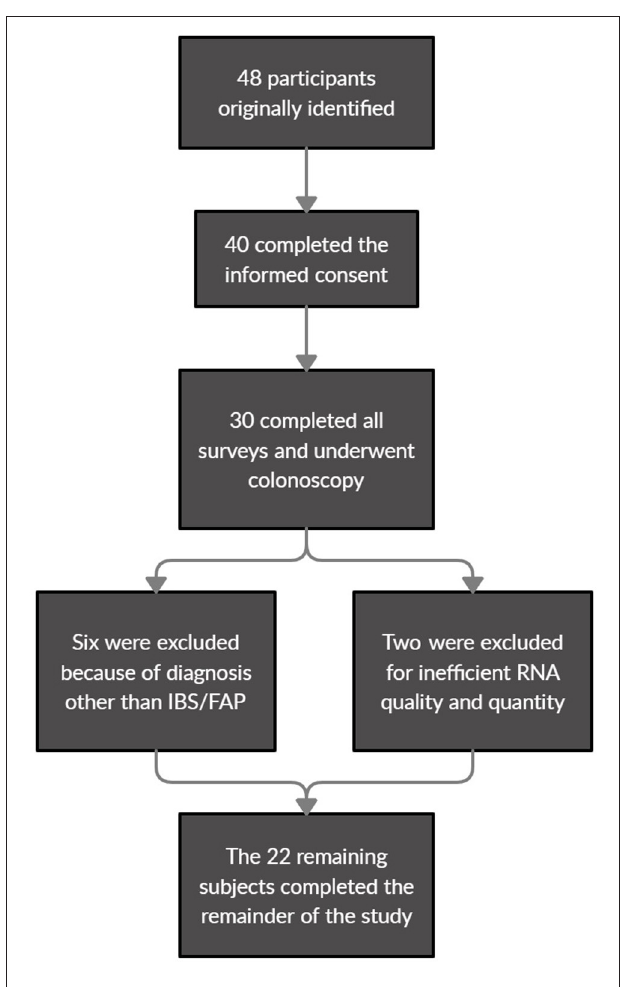
FIGURE 1 | Patient eligibility identification, recruitment, and exclusion flowchart for final